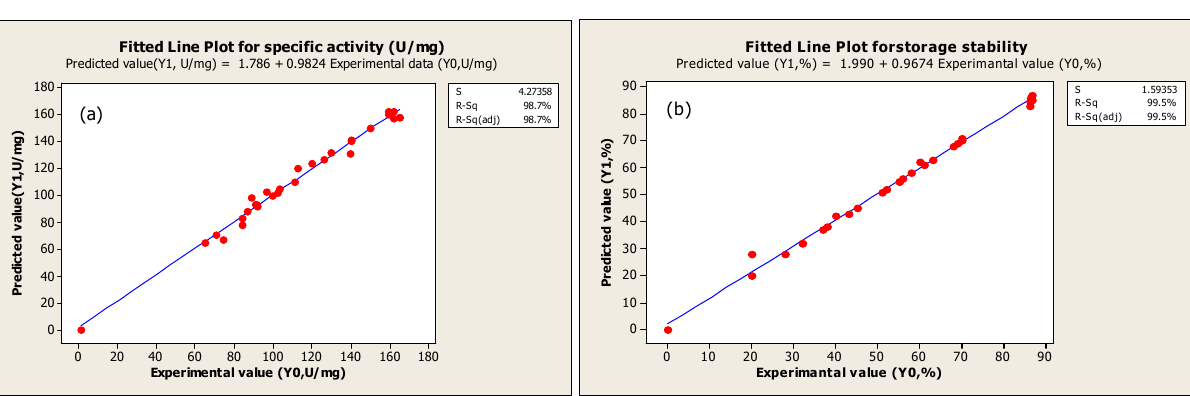
Figure 3. Fitted line plot indicating the closeness between predicted values (Y1) and experimental values (Y0) for specific activity (a), storage stability (b) thermal stability (c), and oxidizing agent stability of serine protease